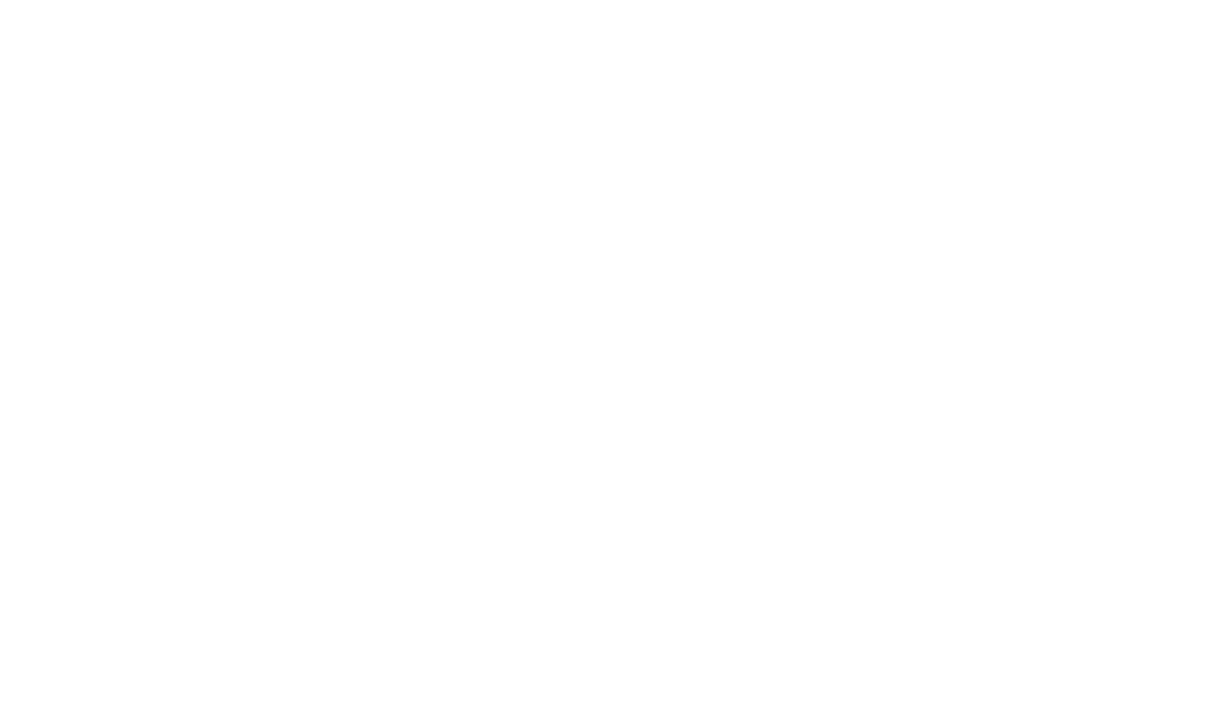
Figure 6. Same as Fig. 5, but from the northeastern coast of Iriomote Island (Group